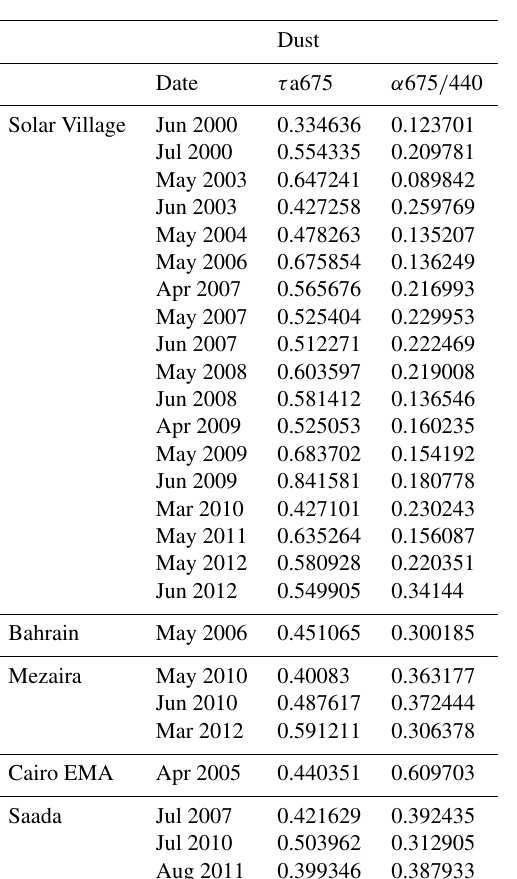
Table 3. Seasonal dust domination over study locations. EMA: Egyptian Meteorology